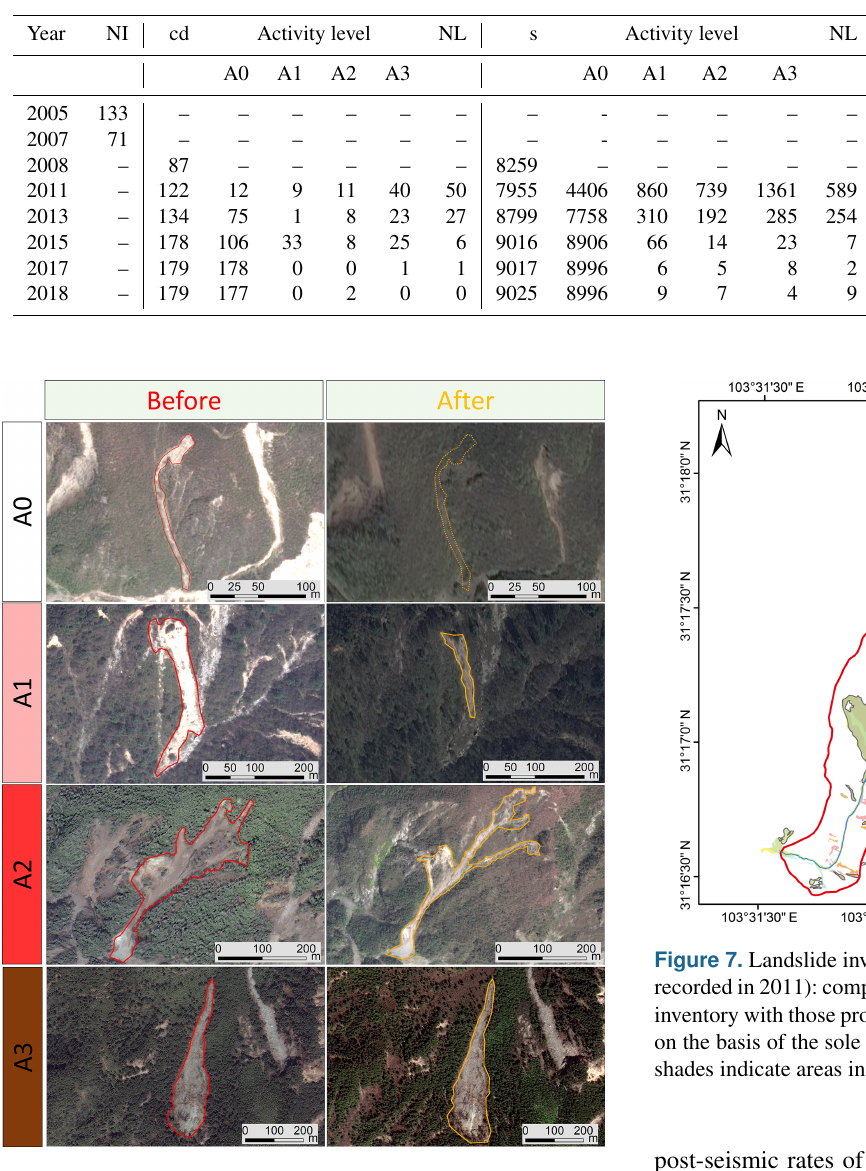
Figure 6. Examples of coseismic landslide deposits displaying dif- ferent levels of activity.